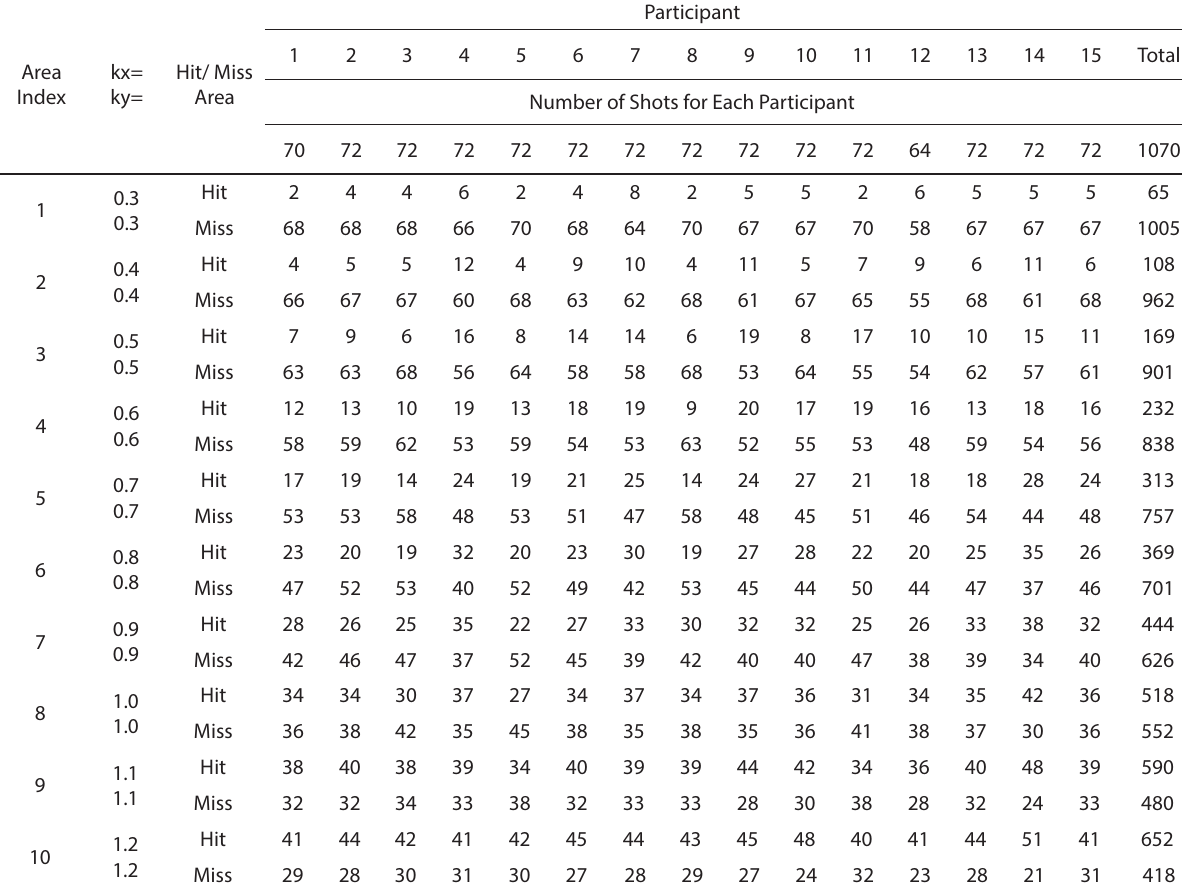
Table 1. Number of arrows shot by each participant and the calculation of hit and miss areas